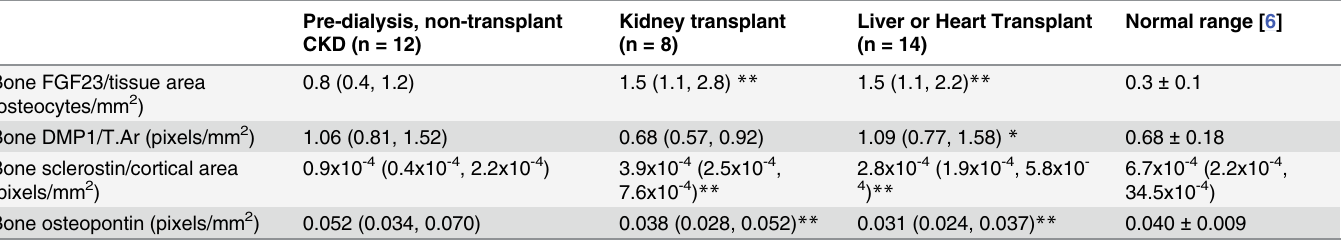
Table 3. Protein expression, as determined by immunohistochemistry, in pediatric transplant and CKD patients.